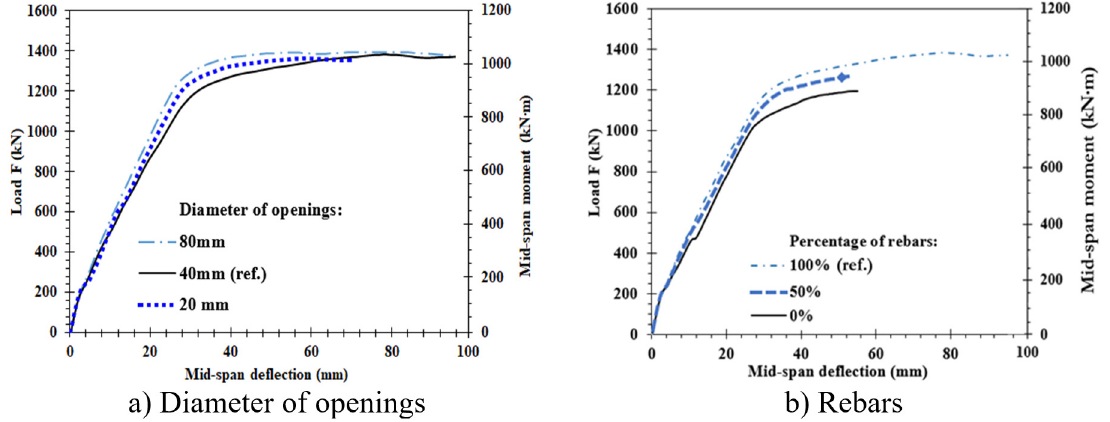
Figure 23. Load-deflection curve – Analyses of CoSFB